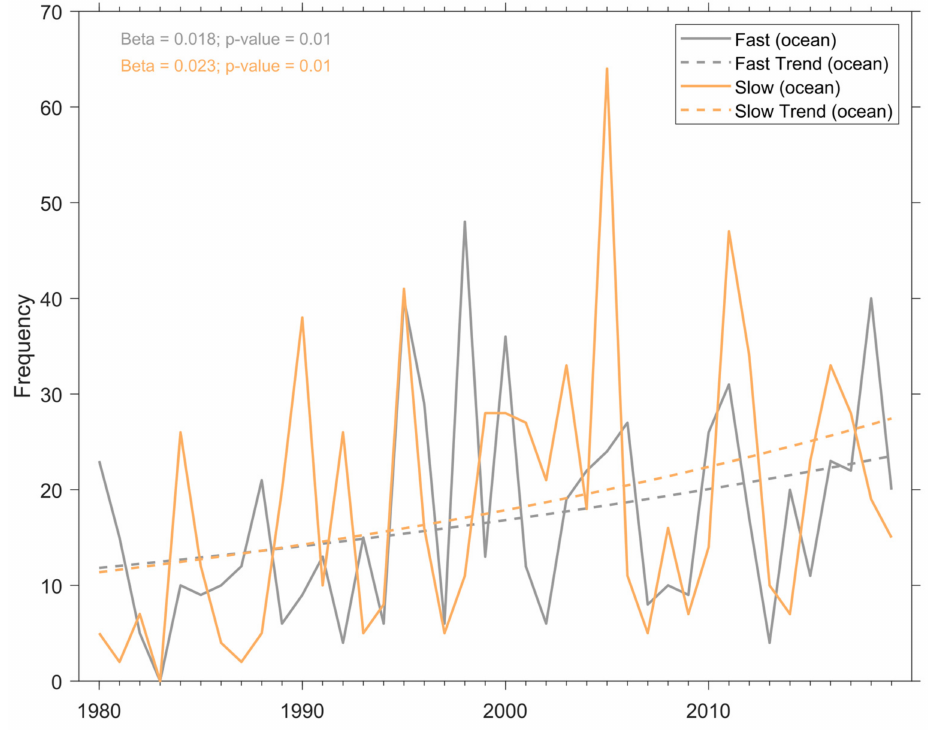
Figure 4. Time series and trend of fast (grey) and slow translation (orange) events over ocean during